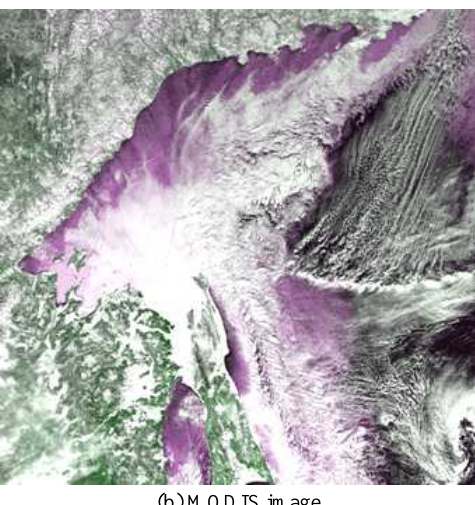
Figure 2. Comparison of AMSR2 and MODIS images. (Sea of Okhotsk, February 27, 2013)